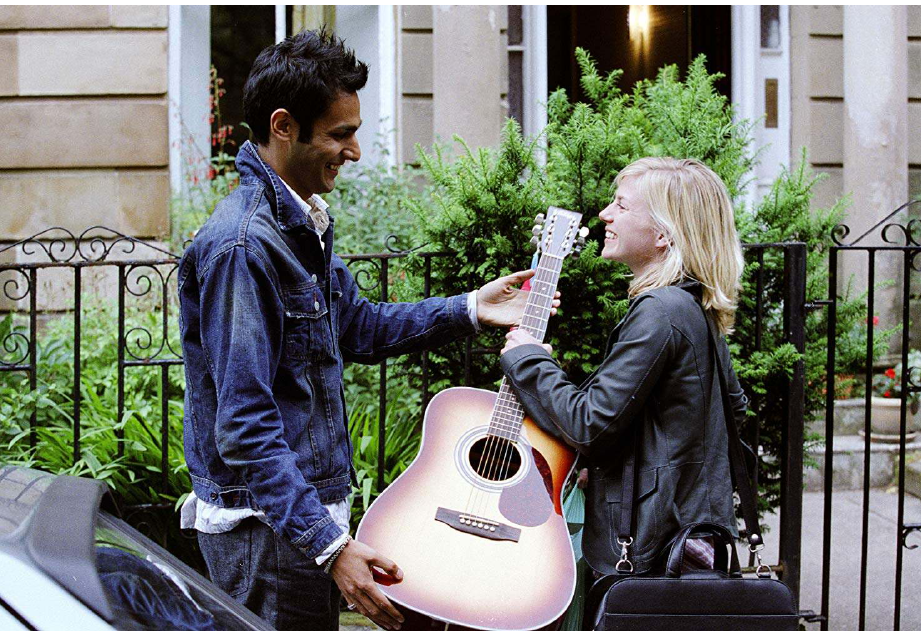
Figure 7. Roisin (Eve Birthistle) and Casim (Atta Yaqub) are first- and second-generation immigrants to